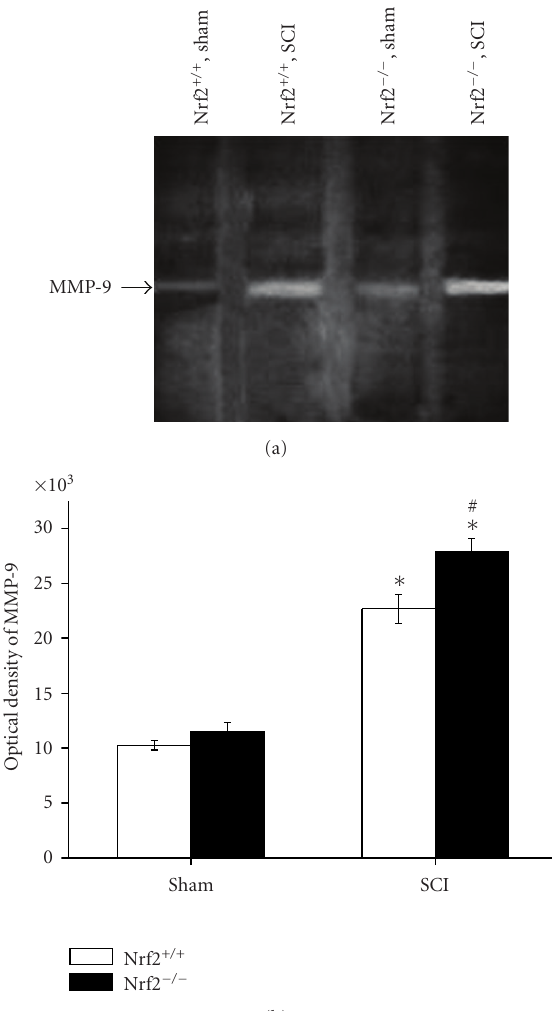
Figure 7: Gelatin zymography analysis for the activity of MMP- 9 in spinal cord tissue of sham and injured Nrf2 (+/+) and Nrf2 ( − / − ) mice. (a) Representative gelatin images show the activity of MMP-9 in sham and injured Nrf2 (+/+) and Nrf2 ( − / − ) mice. (b) The graphs show that higher activity of MMP-9 was found in Nrf2 ( − / − ) mice than in Nrf2 (+/+) mice at 24 hours after SCI. Bars represent mean ± S.E. ( n = 6, each group). ∗ P < . 01 versus genotype-matched sham-operated mice. # P < . 01 versus treatment- matched Nrf2 (+/+)